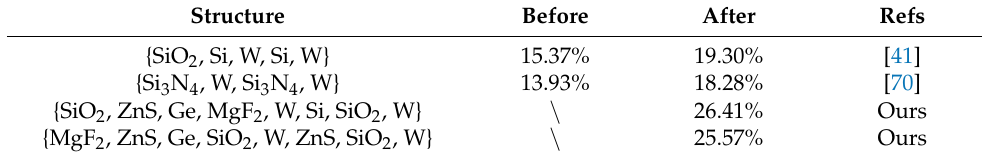
Table 3. Conversion efficiency of the system before and after optimization by BOnSA. Structure